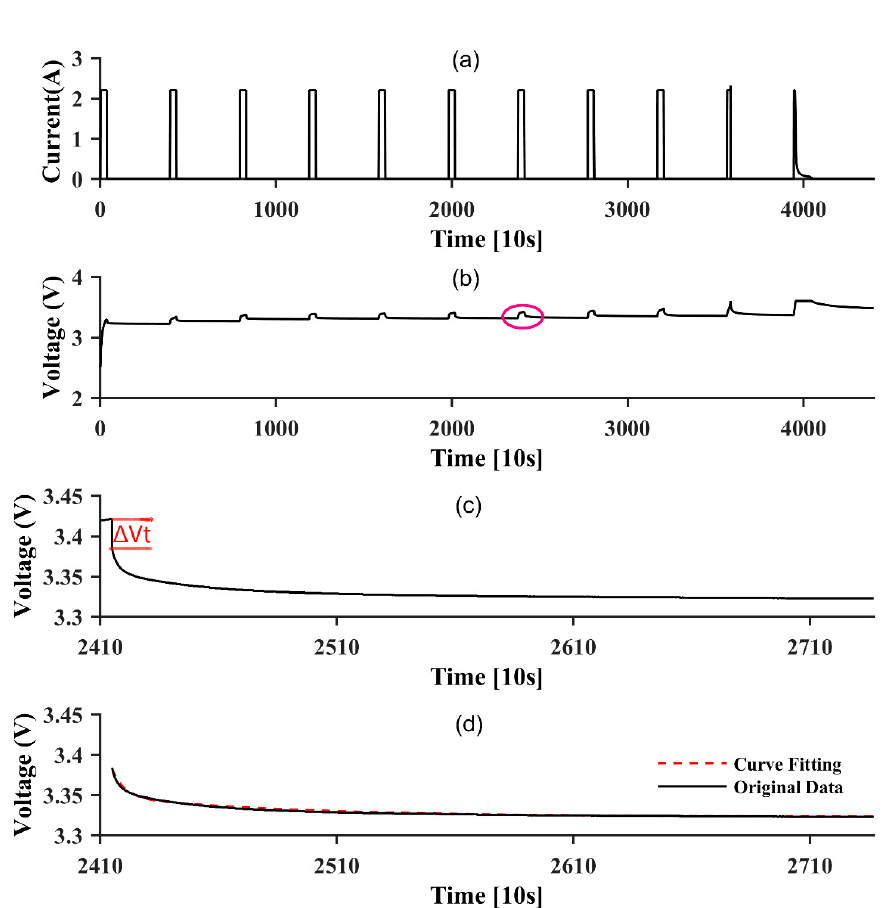
Figure 4. Experimental results of the PCC test ( a ) pulse charge currents; ( b ) terminal voltage responses; ( c ) zoomed transient terminal voltage response corresponding to seventh current pulse; and ( d ) comparison of curve fitting and experimental results.